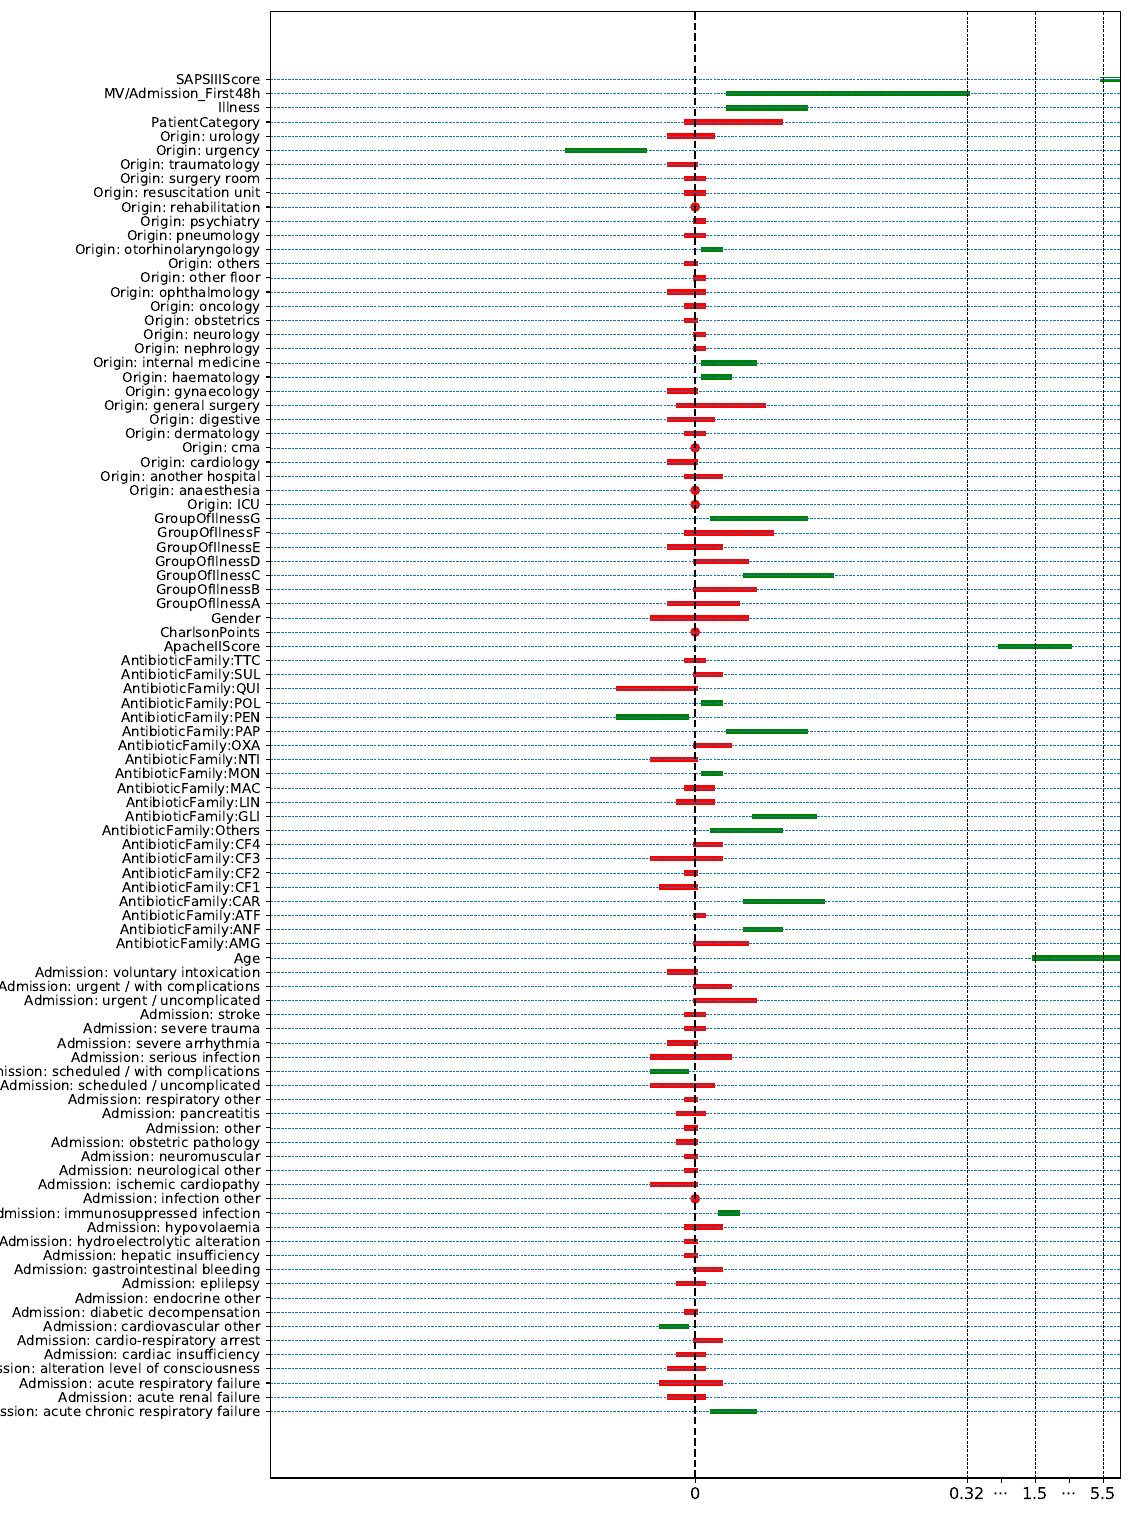
Figure 11. CI for numerical features ( CI ∆ m ) and for binary features ( CI ∆ p ) when bootstrapping MDR and non-MDR patient episodes. The selected features are represented in